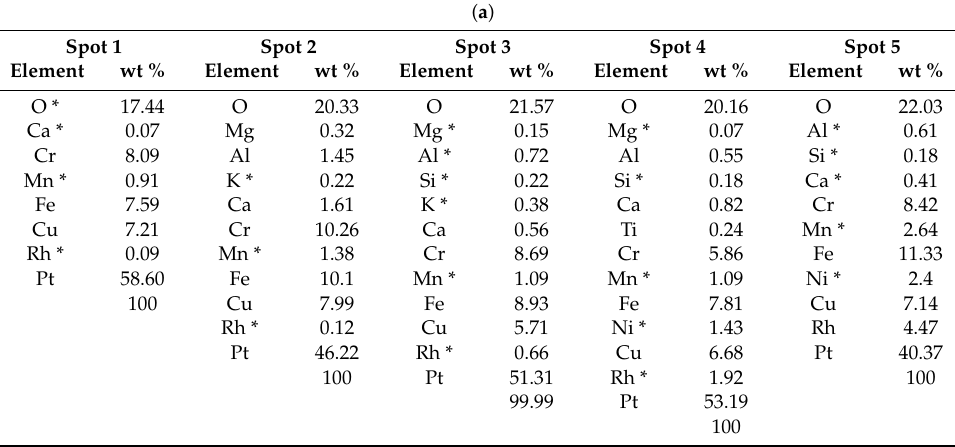
Table10. EDX-measurementsonthetip, Pt-andPt / 10%Rh-wireofthermocouple, respectively. Chemical elements marked with * were added manually as known constituents or impurities. ( a ) Tip of